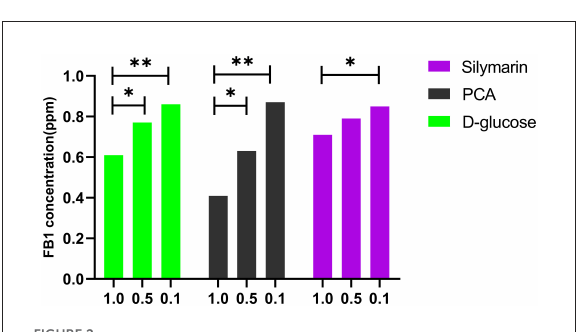
FIGURE2 Effect of D-glucose, PCA, and silymarin on FB1 detoxification post treatment with different concentrations. The dose-dependent manners were detected in the D-glucose-treated group and PCA-treated group using HPLC. Significant detoxification of FB1 was found between 1.0 and 0.5 mol/L of concentrations in the above two groups at 80 ◦ C for 2h, while a statistical difference was determined between 1.0 and 0.1 mol/L of the silymarin-treated groups at 60 ◦ C for 0.5h ( p <